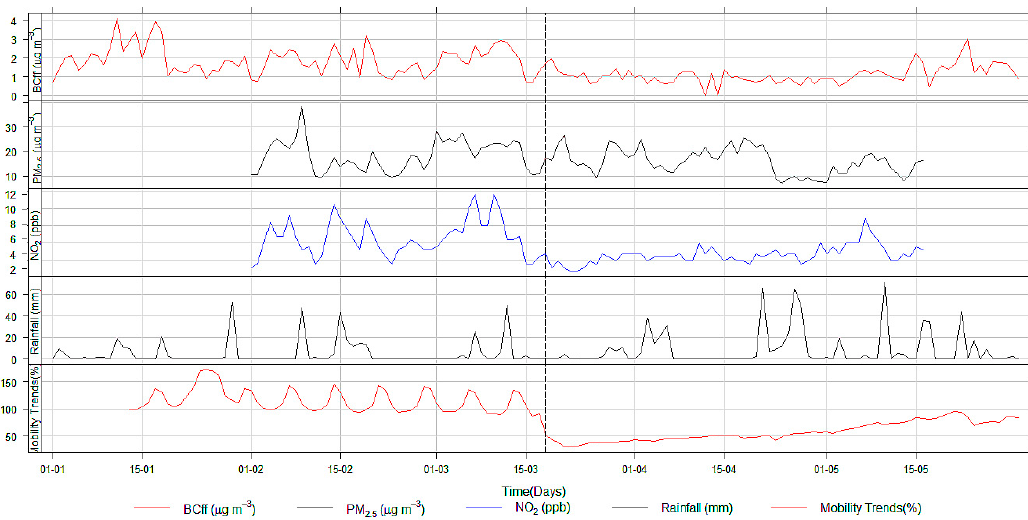
Figure 6. Time series of concentrations of daily mean BCff ( µ g/m 3 ), PM 2.5 ( µ g/m 3 ), NO 2 (ppb), rainfall (mm) and relative mobility trends (%). The MCO for COVID-19 lockdown came into force on 18 March (shown by the vertical dotted line) and remained in place for the remainder of the time series.